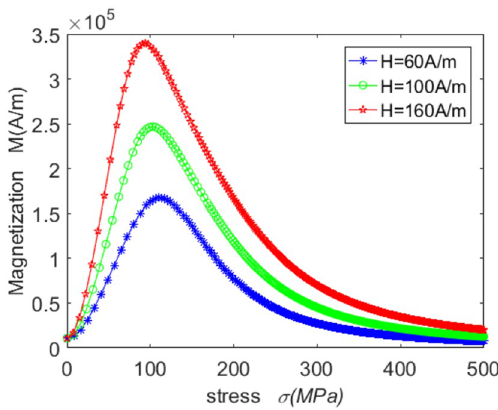
Fig. 2 Variation curves of magnetization intensity with stress in dif- ferent magnetic field